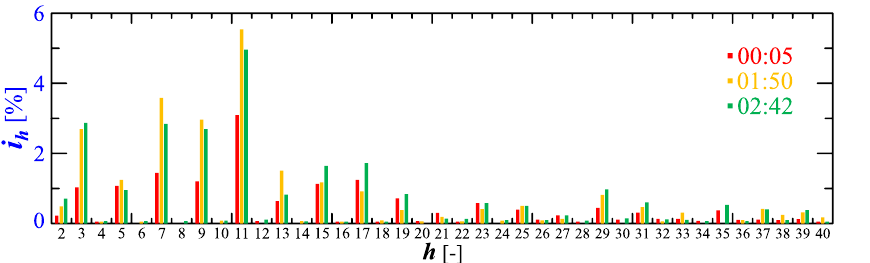
Figure 20. The amplitude spectrum of the current i h = f ( h ) recorded at 00:05, 1:50, and 2:42 for Case II.